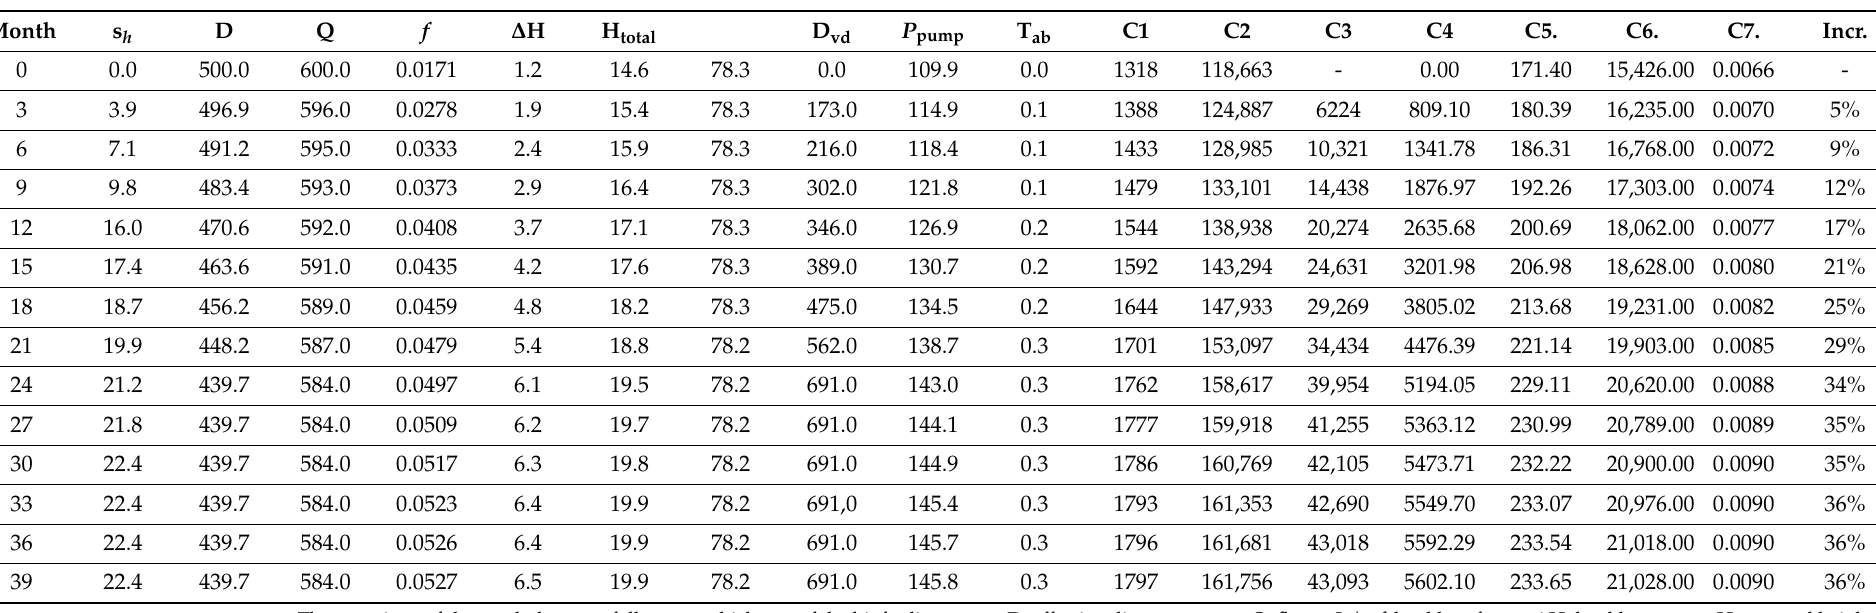
Table 4. Progression of consumption and costs, in view of the progression of GM bioinfestation for Pump 1, with a flow rate of 600 L/s and a diameter of 500 mm.